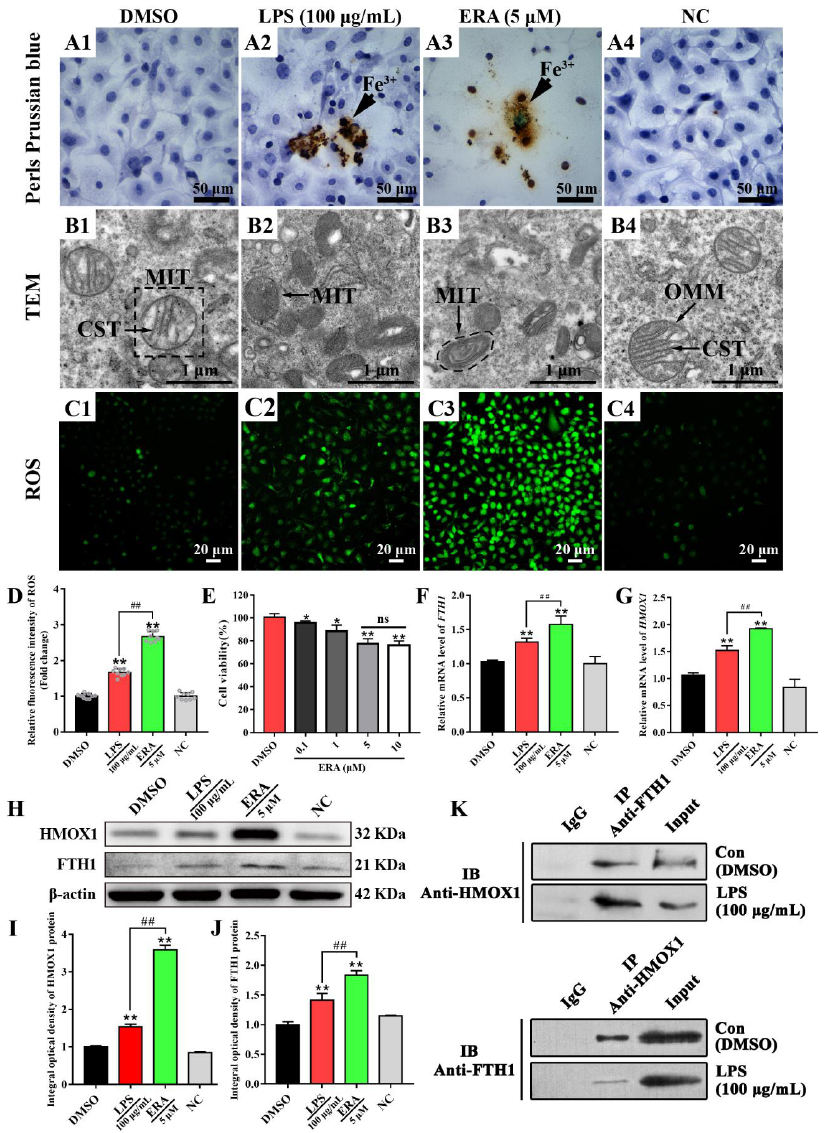
Figure 6. HMOX1 promotes ferroptosis via the FTH1 dependent pathway in LPS induced inflamma- tion model in MAC-T cells. ( A ) Positive staining of ferric iron (Fe 3+ ) in MAC-T cells treated with or without DMSO, NC, LPS (100 µ g/mL) and ERA (5 µ M) using Perls Prussian blue staining. ( B ) Mor- phology of the mitochondria was observed in the DMSO, NC, LPS and ERA groups using TEM. ( C ) ROS fluorescence signals in MAC-T of the DMSO, NC, LPS and ERA groups using DCFH-DA fluorescence probe. ( D ) The relative fluorescence intensity of ROS in the MAC-T of the DMSO, NC, LPS and ERA groups. ( E ) Cell viability analysis of MAC-T cells treated with ERA (0.1–10 µ M) using a CCK8 kit. ( F , G ) Relative expression level analysis of HMOX1 and FTH1 mRNA in MAC-T cells treated with or without LPS (100 µ g/mL) and ERA (5 µ M) using qRT-PCR. ( H ) Western blot expres- sion analysis of HMOX1 and FTH1 proteins in MAC-T cells treated with or without LPS (100 µ g/mL) and ERA (5 µ M). ( I , J ) The IOD values of HMOX1 and FTH1 proteins in MAC-T cells treated with and without LPS (100 µ g/mL) and ERA (5 µ M). ( K ) The Co-IP analysis of the FTH1 and HMOX1 proteins in MAC-T cells treated with and without LPS (100 µ g/mL). Con/C, Control, treated with DMSO (0.1% v/v ). LPS, experimental group, treated with LPS. ERA, experimental group, treated with ERA (5 µ M). NC, negative control. IP, immunoprecipitation. IB, immunoblotting. Scale bar of 50 µ m, 1 µ m and 20 µ m represents 400 × , 15,000 × and 400 × , respectively. Statistical analyses: one-way ANOVA, α = 0.05. Data are presented as means ± SEM. * represents p < 0.05, ** or ## represents p <